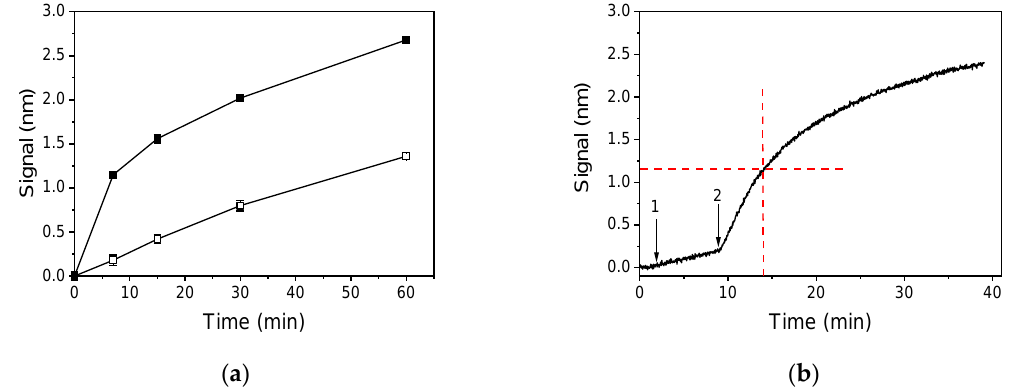
Figure 4. ( a ) Effect of primary immunoreaction duration on the zero calibrator signal without (open squares) or with an additional 5-min reaction with an anti-mouse IgG antibody (closed squares). Each point is the mean value of 3 measurements ± SD. ( b ) Real-time response corresponding to zero DON calibrator when running over a chip coated with a 200 μg/mL DON-OVA solution: assay buffer (start to arrow 1; 2 min), 1:1 ( v / v ) calibrator/anti-DON mAb mixture (arrow 1 to 2; 7 min), and anti-mouse IgG antibody (arrow 2 to 3; 30 min). The dashed red lines indicate the signal received for running the anti-mouse IgG antibody for 5 min.